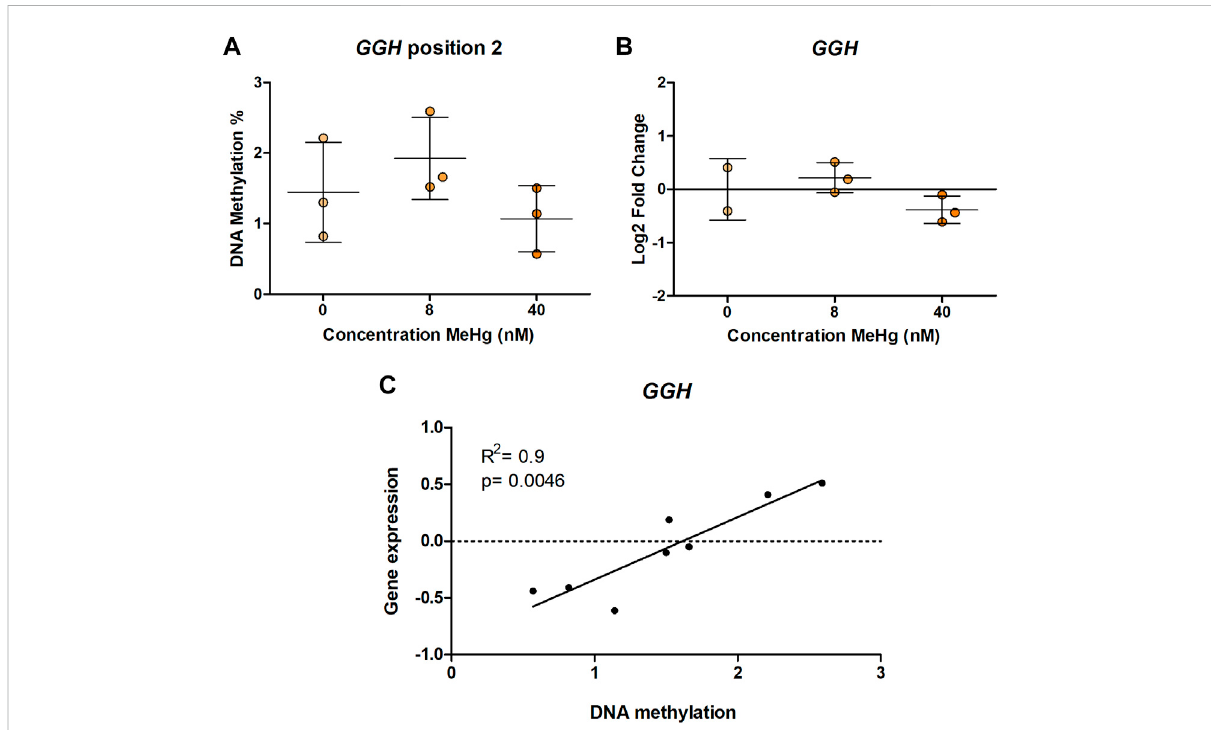
FIGURE 2 GGH DNA methylation and gene expression in MeHg-exposed SH-SY5Y cells; (A) DNA methylation levels, (B) gene expression, and (C) Spearman correlation between gene expression and DNA methylation. The results are presented as the mean ± SD of three independent biological replicatesand wereanalyzed withOne-way Analysis ofvariance (ANOVA)with Dunnett ’ spost-hoctest.Statisticalsigni fi cance wasconsideredwhen the p -value was below